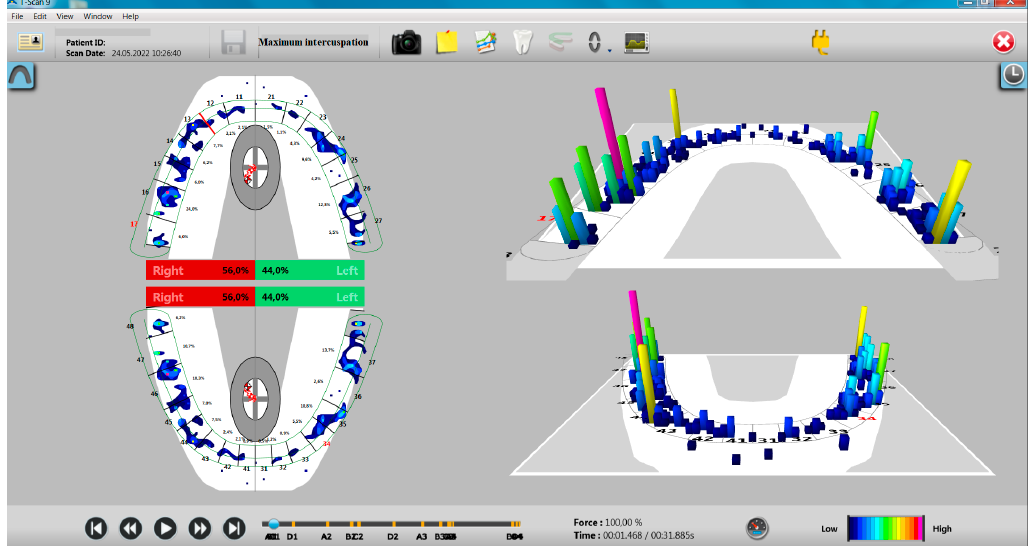
Figure 2. Aspects of T-Scan recording in MI for a participant without bruxism.